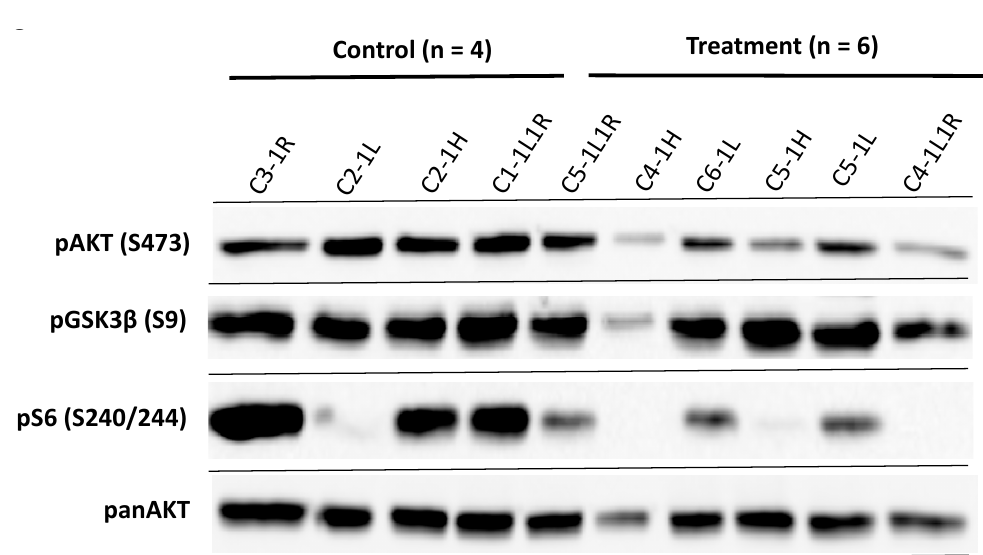
Figure 5. Western blot analysis of MPNST S462sp xenograft tumours confirms the activity of AKT and mTOR inhibitors in vivo. Mice in both groups bearing S462sp xenograft tumours (as shown in Figure 4) were sacrificed after 28 days and tumours carefully excised. The protein lysates were prepared as described previously [25] and probed in a western blot analysis with primary antibodies targeting phospho-AKT (S473), panAKT, phospho-GSK3ß (S9) and phospho-S6 (S240/244).